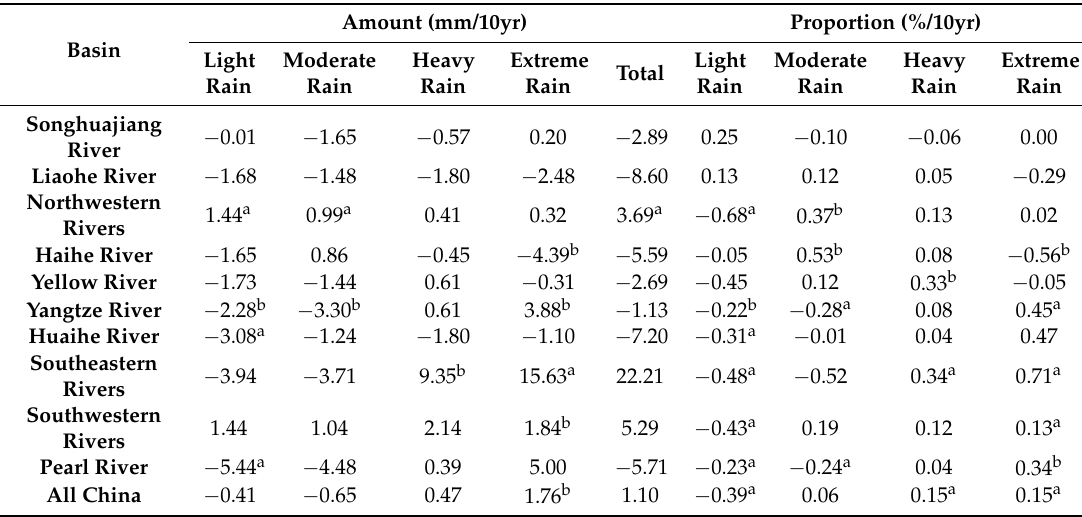
Figure 2. Trends in annual precipitation for 1960–2013. A plus/triangle shows a positive/negative trend for each station with statistical significance at the 5% level. Table 1. Trends in amounts and proportion of precipitation in each category in the large river basins in China during 1960–2013.